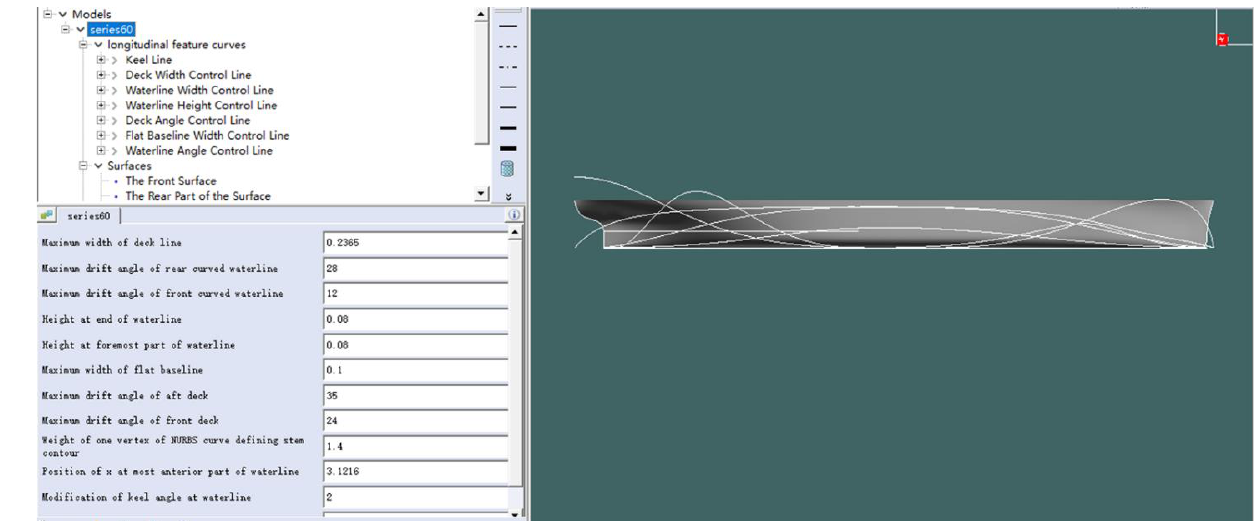
Figure 4. The interface of parametric modeling software for ship models.